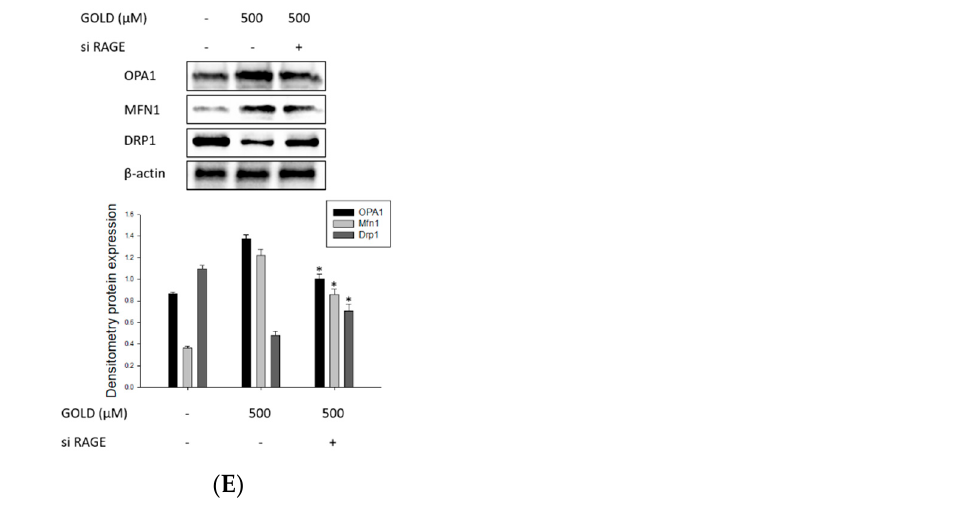
Figure 6. Changes in signaling through RAGE suppression. Effects of RAGE on GOLD-stimulated SV40 MES 13 cells. ( A ) SV40 MES 13 cells were transfected with control small interfering RNA (siRNA) or RAGE siRNA and then treated with GOLD. ( B ) SV40 MES 13 cells were transfected with RAGE siRNA and then stimulated with GOLD (500 μ M) for 30 min. ROS levels were determined using confocal microscopy. ( C , D ) Protein levels of NRF2, GLO1, and proinflammatory cytokines were determined using Western blotting, with β -actin as an internal control. ( E ) Mitobiogenesis was measured by detecting mitochondrial genes in SV40 MES 13 cells. Data are expressed as the mean ± SEM of three independent experiments. * p < 0.05 indicates a significant difference compared to the GOLD-treated group.